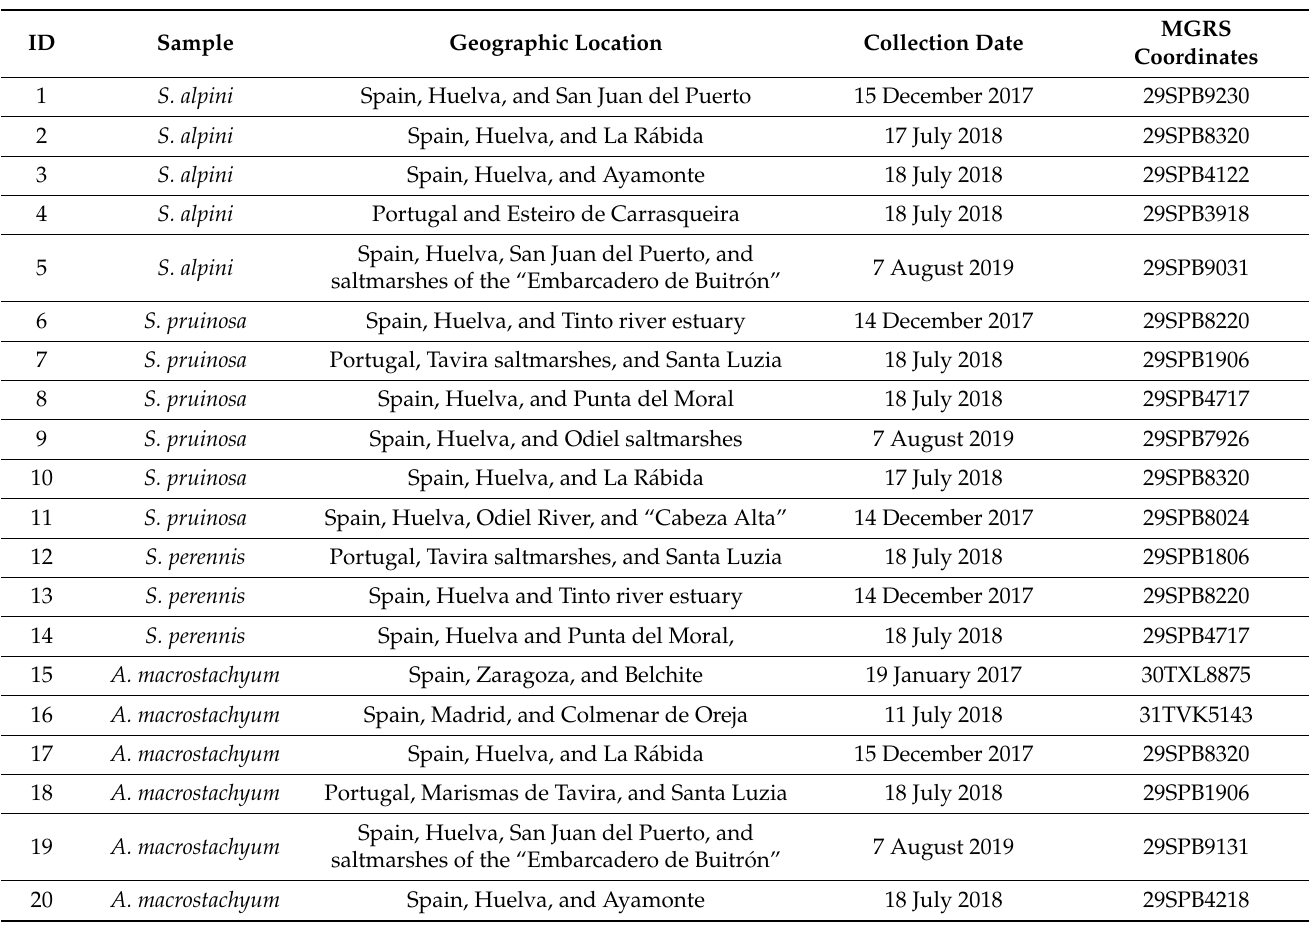
Table 3. Data on the material: geographic locations, collection date, and MGRS (Military Grid Reference System) of the S. alpini , S. pruinosa , S. perennis , and A. macrostachyum samples from the Iberian Peninsula (Spain and